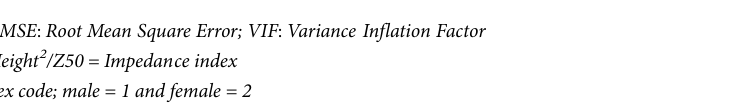
The Bland and Altman approach used to plot the difference between the measured and pre- dicted values against their means showed a small error and non-significant bias for TBW (0.11 kg±0.91; P = 0.279) and %BF (0.19% ±5.6; P = 0.764). The limits of agreements ranged from -1.67 to 1.89 and -10.78 to 11.17% for TBW (Fig 3) and %BF, respectively (Fig 4). Four outliers were observed in the Bland and Altman TBW plot.